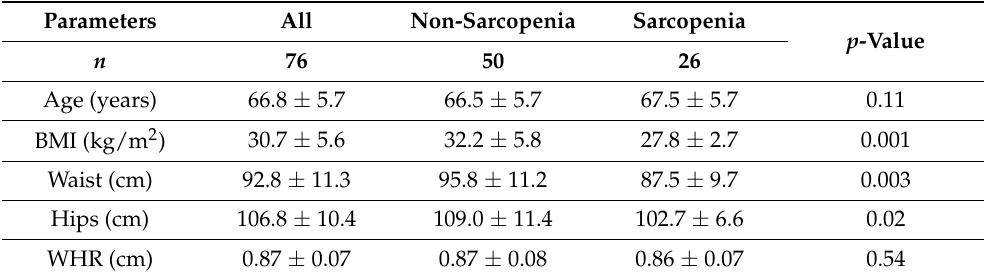
Table 2. Differences in age and anthropometrics according to sarcopenia status.